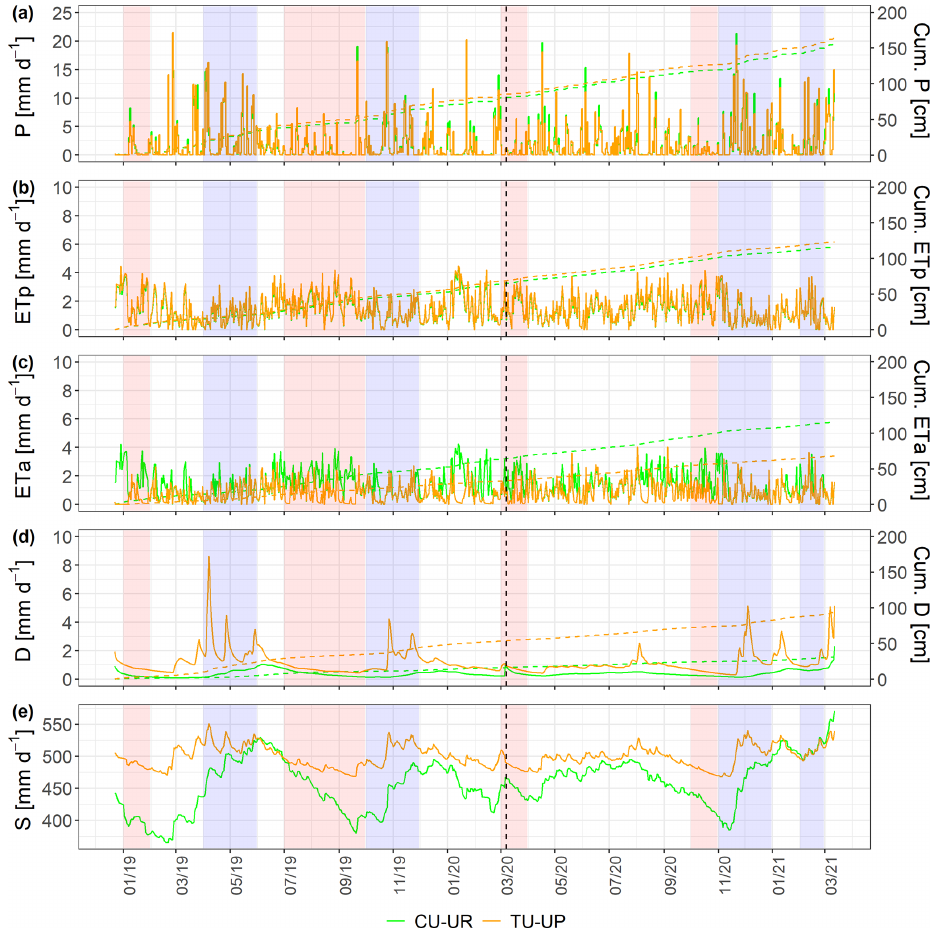
Figure 6. Soil water balance at a daily scale: (a) rainfall ( P ), (b) potential evapotranspiration (ETp), (c) actual evapotranspiration (ETa), (d) deep drainage ( D ), and (e) soil water storage ( S ) (vertical dashed line separates calibration and validation periods). The green and brown lines represent the CU-UR and TU-UP profiles, respectively. Red stripes represent months defined as dry periods, while blue stripes represent months defined as wet periods. Table 3. Mean annual water balance (January–December 2019 to January–December 2020) and the corresponding percentage of rainfall input (mean ± 2standard